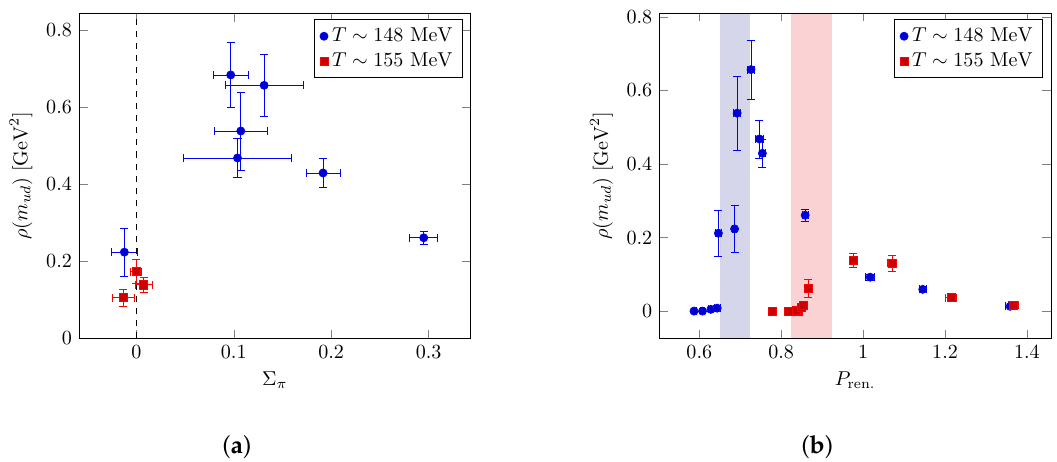
Figure 3. ρ ( m ud ) as a function of µ I , as obtained at various temperatures on 16 3 lattices. For the latter case only two temperature values are displayed. The lower (upper) edge of the shaded areas is set by the µ I value at which the pion condensate Σ π becomes nonzero (the renormalized Polyakov loop P r becomes 1) in the same setup.